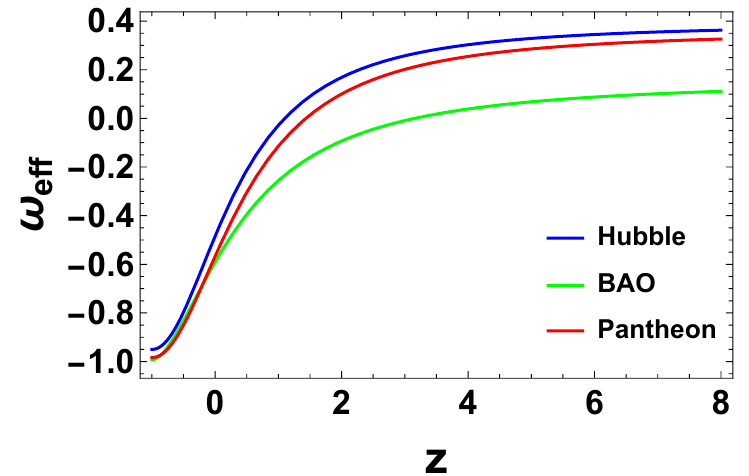
Figure 8. Profile of the EoS parameter for the given model corresponding to the values of the parameters constrained by the Hubble, BAO, and Pantheon data point